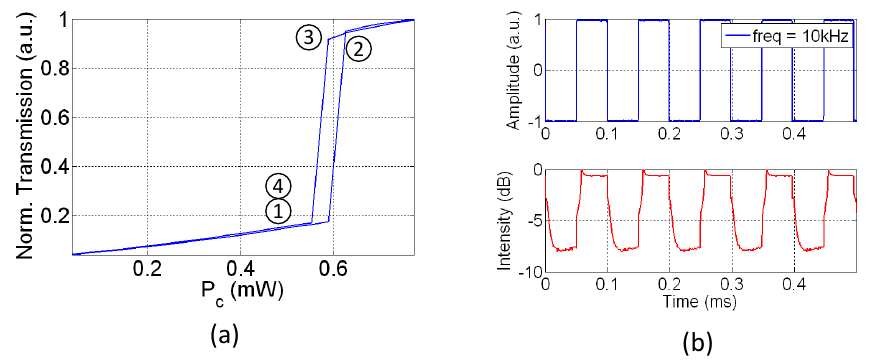
Figure 8. ( a ) Measured transmitted power of the grating device as a function of injected power showing hysteresis effects. The laser wavelength was set on the red side of the cold cavity resonance peak; ( b ) Input modulation signal and micro-resonator response for thermal bistability